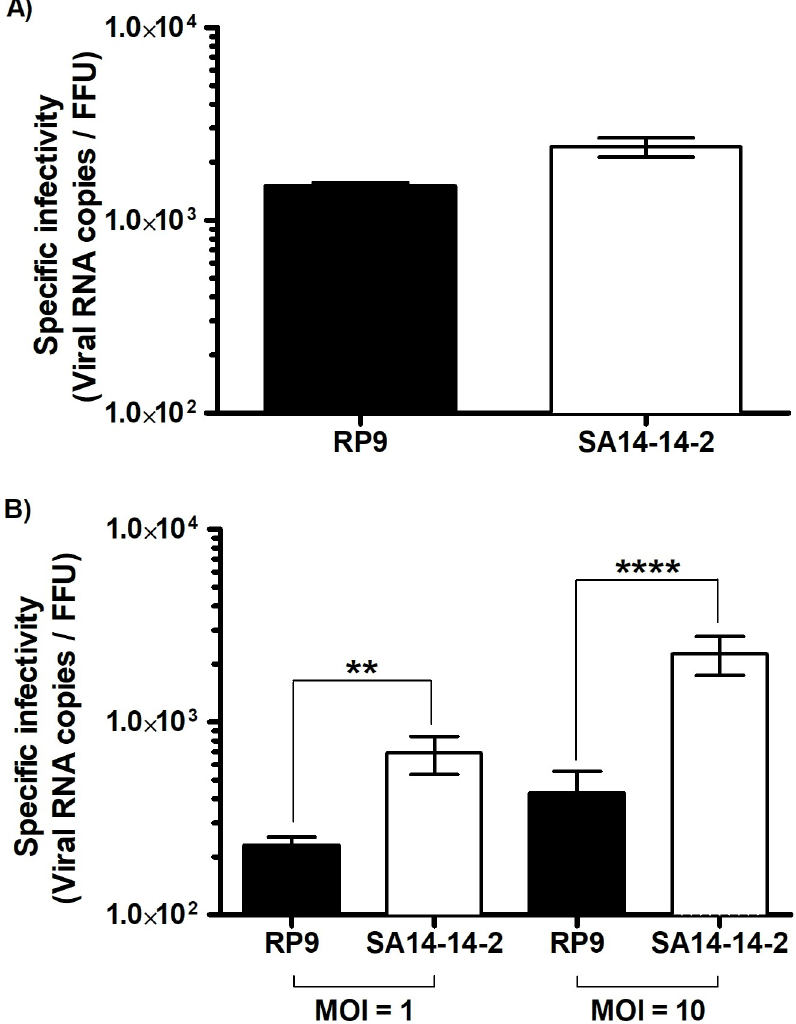
Fig 5. The specific infectivity of JEV RP9 is decreased after BBB-crossing. A) Both the number of viral RNA copies and the infectious titers for either JEV RP9 or JEV SA14-14-2 stock used for the JEV BBB-crossing experiments were determined as described in Material and Methods. The specific infectivity of both stocks, calculated by dividing the viral RNA copies number/ml by the FFU/ml of each viral stock, was evaluated after 6h incubation at 37˚C. B) The specific infectivity of the JEV RP9 and SA14-14-2 BBB-crossing samples was calculated as indicated above using the data from Fig 4B and 4C. The arithmetic means ± standard deviation of at least two independent experiments performed in triplicate is shown. Asterisks indicate a significant difference between the specific infectivity of RP9 and SA14-14-2 for each MOI evaluated in the BBB-crossing experiments ( �� , P = 0.0022; ���� , P < 0.0001).